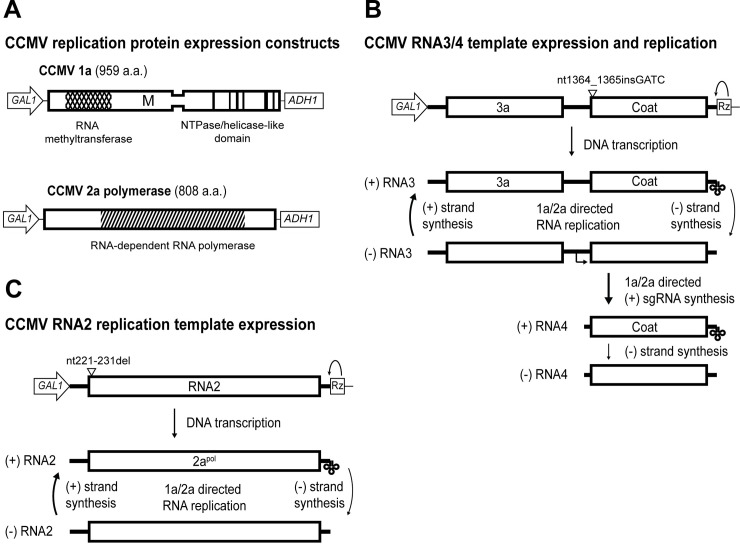
DNA launched CCMV 1a, 2a, RNA3, and RNA2 expression and replication.(A) The open reading frames for CCMV 1a and 2a from RNA1 and 2 respectively were cloned in between the yeast GAL1 promoter and the yeast ADH1 terminator. These constructs will express the viral proteins, but lack essential non-coding viral sequence required for RNA replication. Highly conserved regions of 1a responsible for methyltransferase activity (diamonds), membrane association (‘M’), and predicted helicase domains (vertical bars) are indicated. The core RNA-dependent RNA-polymerase domain of 2apol is indicated by striping. (B) Full CCMV RNA3 cDNA sequence was cloned between the GAL1 promoter and a ribozyme (Rz) derived from hepatitis delta virus that cleaves itself from the RNA leaving the natural viral 3’end. CCMV 1a and 2apol proteins direct negative-strand synthesis of RNA3, which then serves as a template for additional positive strand synthesis of both RNA3 and the subgenomic RNA4. Expression of the coat protein depends on synthesis of (+)RNA4 from the (-)RNA3 template, but is intentionally blocked in this construct by an introduced frameshift mutation. (C) Full-length CCMV RNA2 cDNA was cloned between the GAL1 promoter and ribozyme as for CCMV RNA3. A small deletion in this construct disrupts the 2apol ORF and blocks cis- expression of 2a from the template.